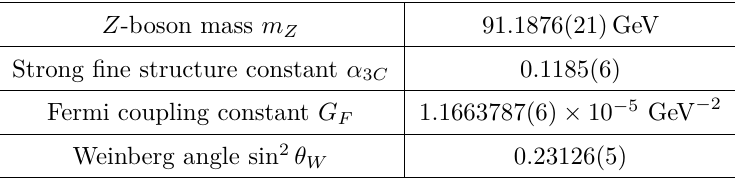
Table 5. Experimental observables at m Z